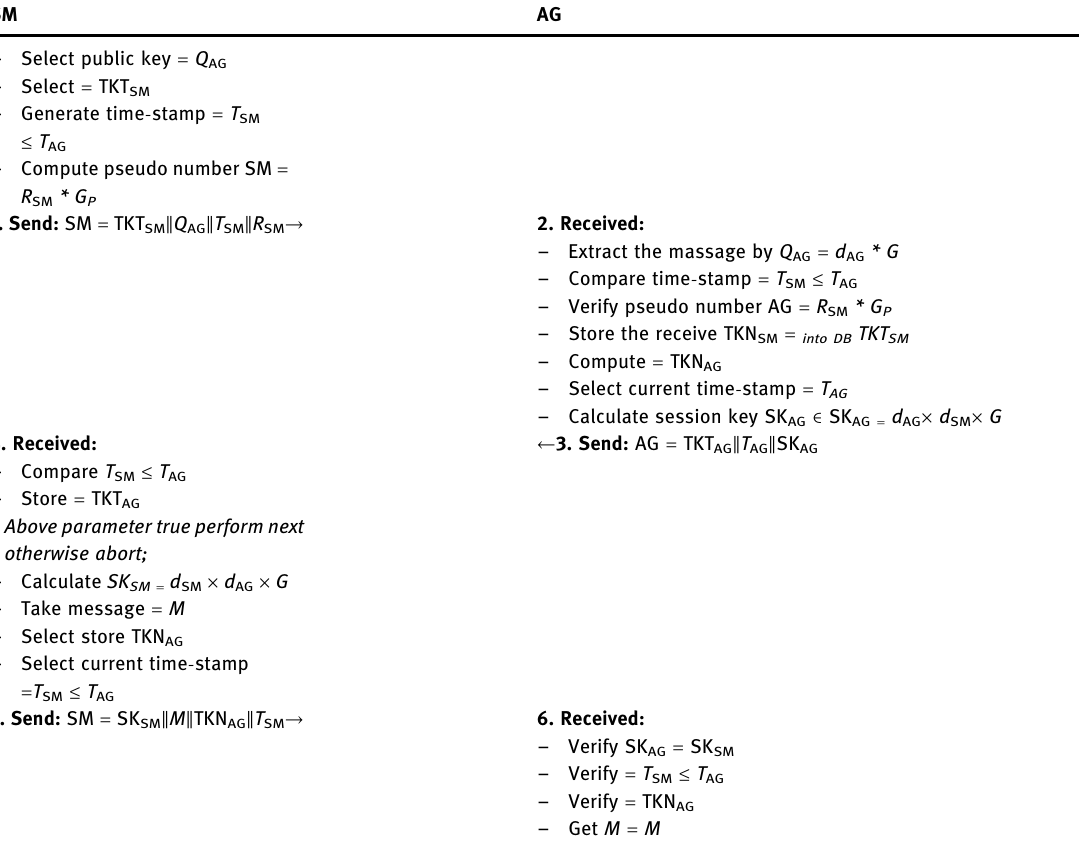
Table 3: Flow mutual authentication phase SM